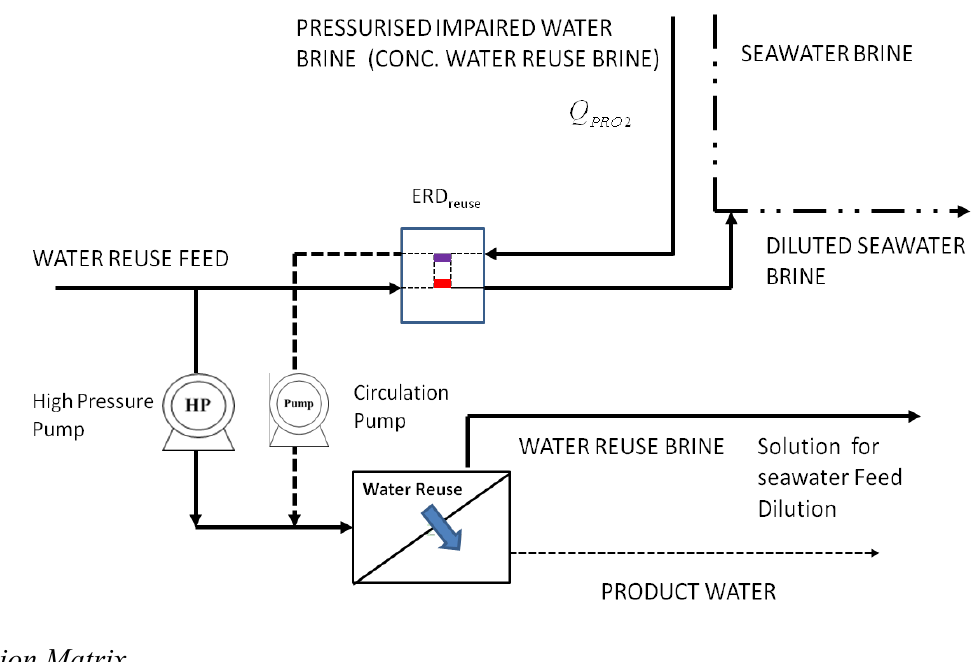
Figure 5. Water reuse process with non-isobaric ERD, ERD